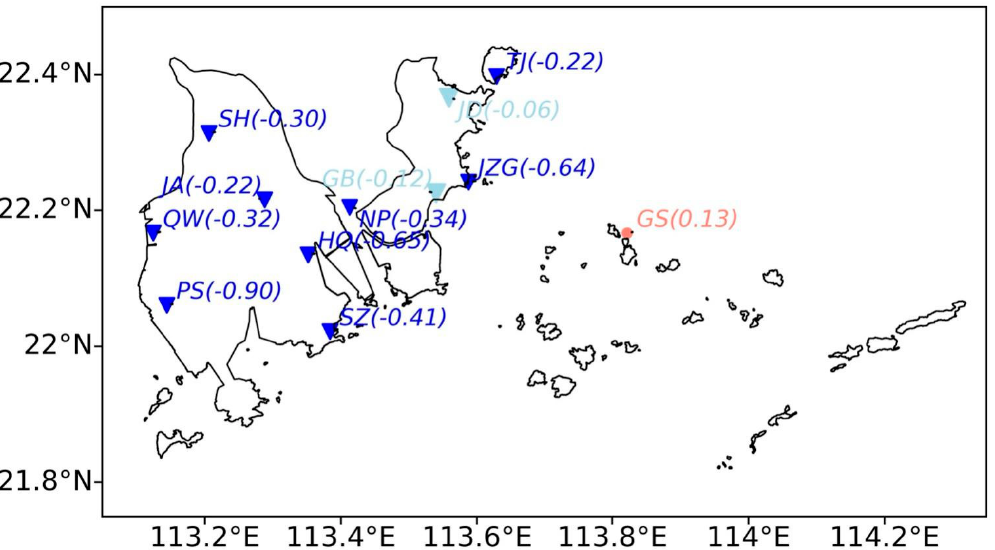
Figure 5. Inter-annual variations of SWS (m s − 1 ) averaged over Zhuhai from anomalies of observa- tions (OBS) and reanalysis (ERA5), as well as from OMR methods.